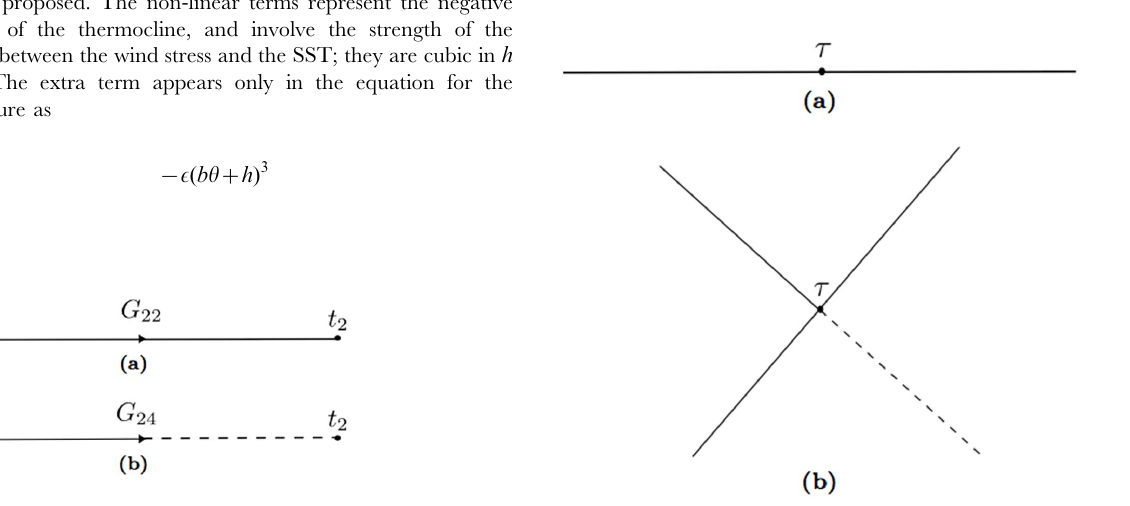
Figure 6. The internal vertex t . (a) for the quadratic term z 2 the the quartic term z